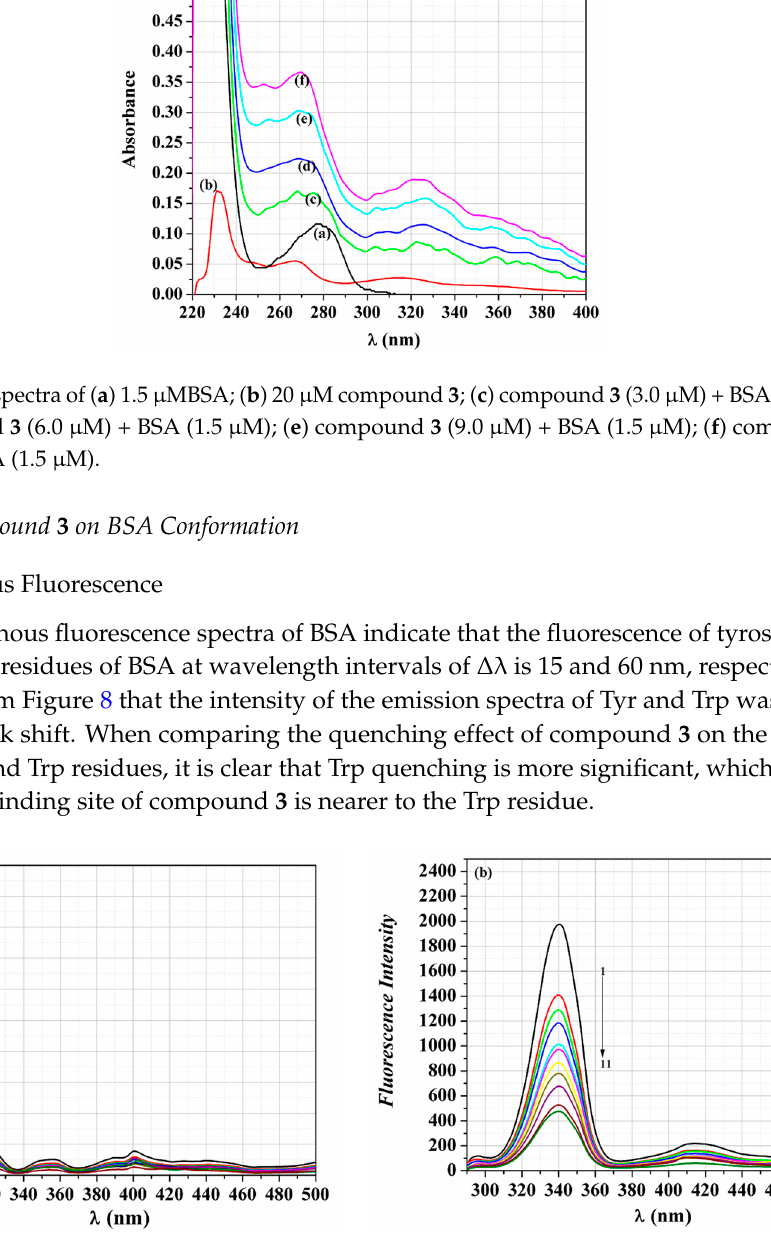
Figure 8. Spectra of the synchronous fluorescence of BSA (1.5 μ M) with the addition of compound 3 (1–11) = (0–25 μ M) at Δλ = 15 nm ( a ) Δλ = 60 nm ( b ).